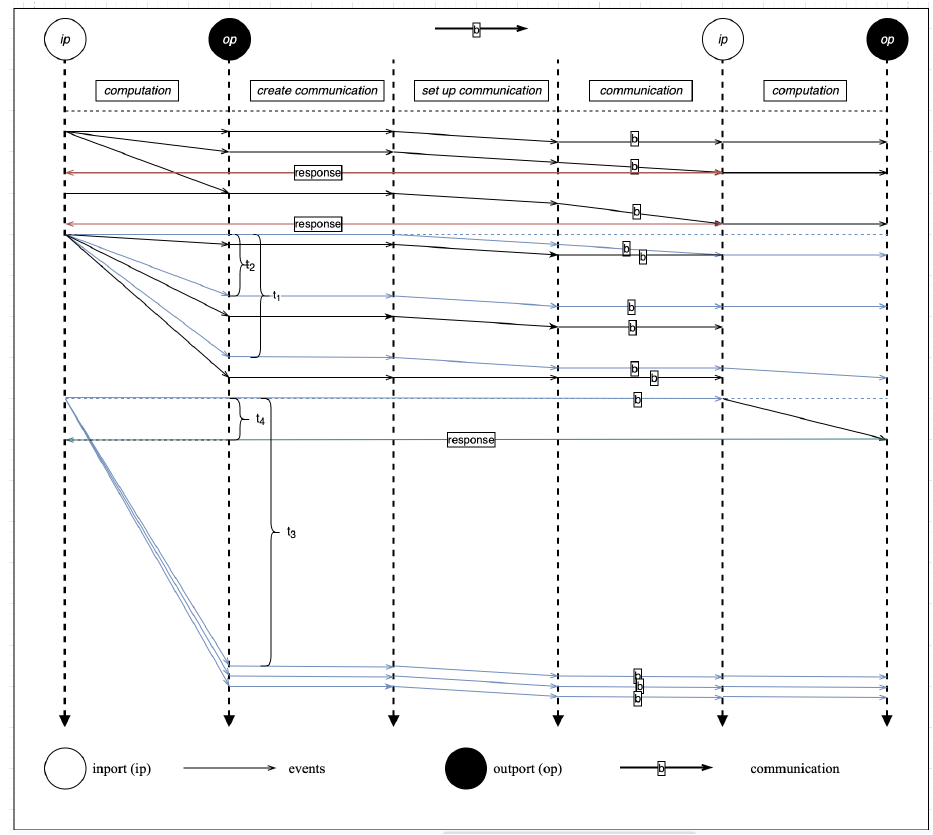
Figure 10. Runtime Event